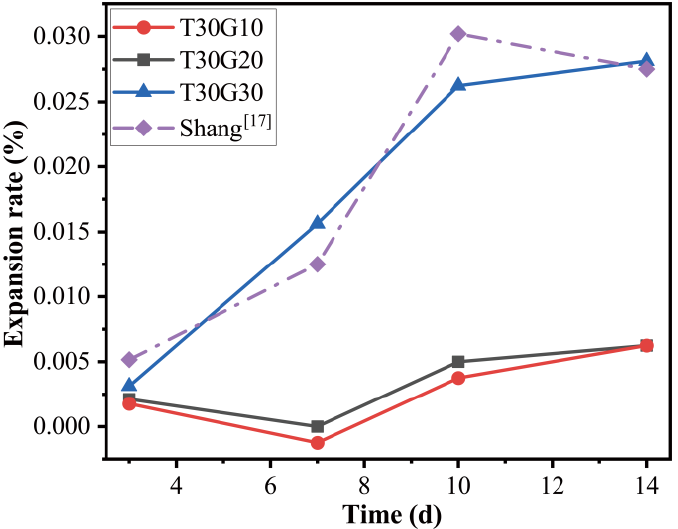
Figure 16. Effect of recycling glass content on the expansion rate of mortar. Table 6. The leaching amount of heavy metals from MSWI fly